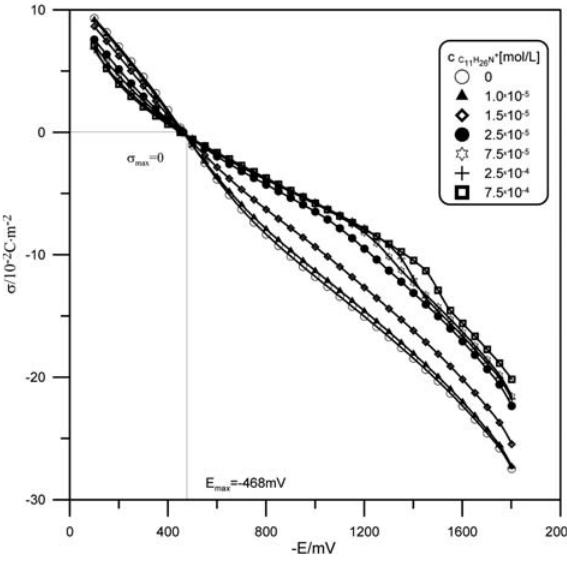
Figure 2. Dependences of the electrode charge versus the electrode potential for the studied C